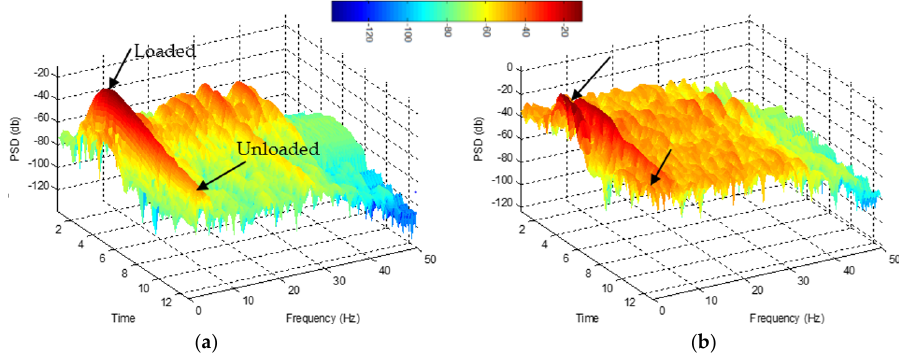
Figure 14. Time-frequency acceleration measurements for the trains speeds ( a ) 290 km/h and ( b ) 406 km/h.